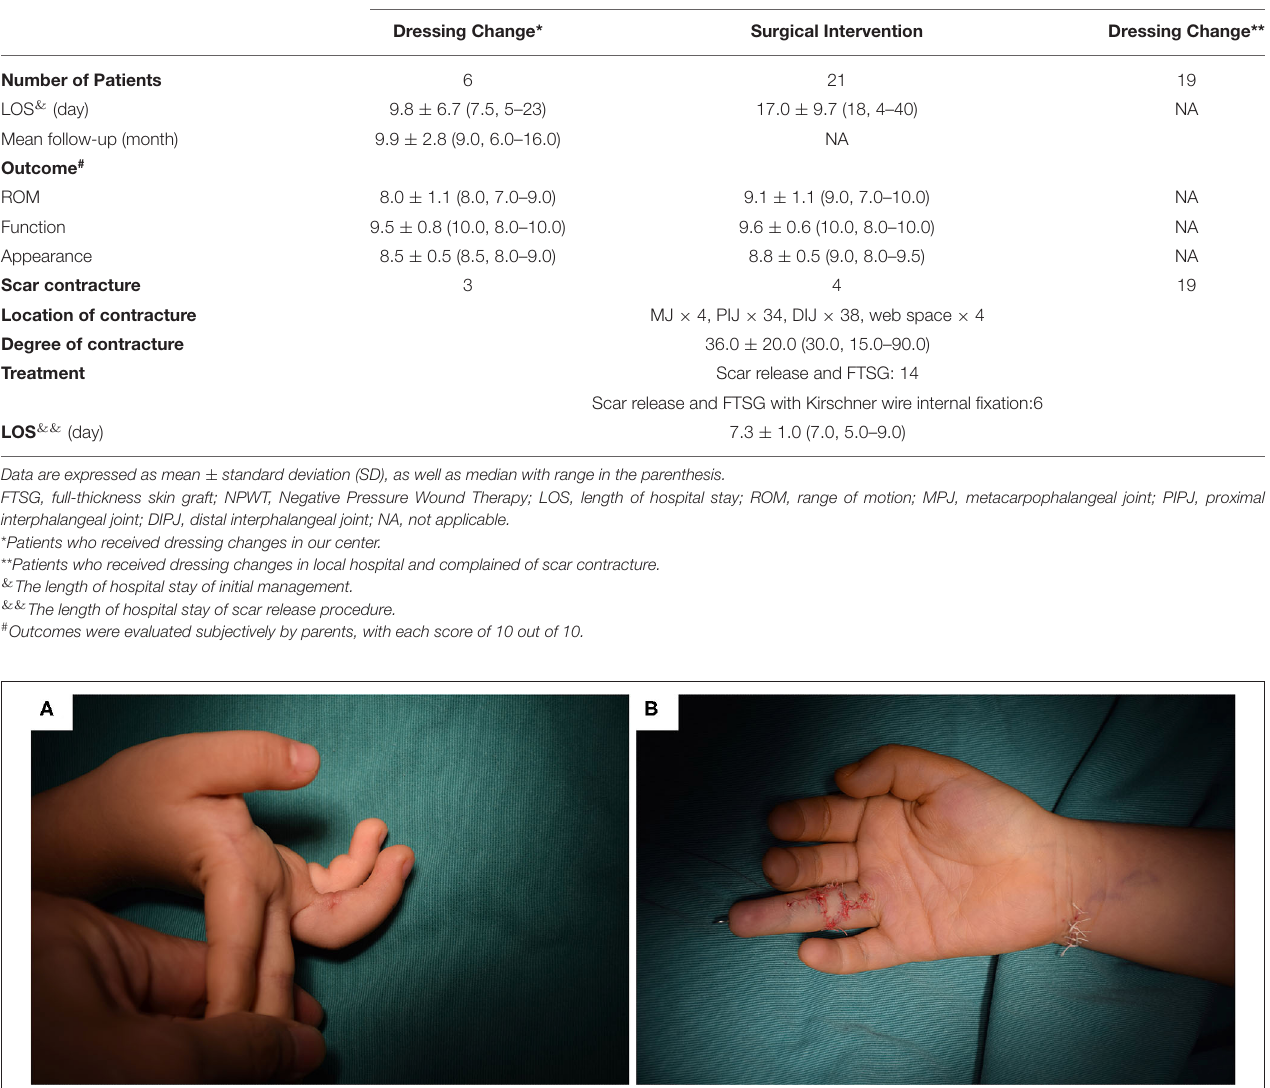
TABLE 3 | The prognosis of different managements, as well as further treatments of the complication (scar contracture).